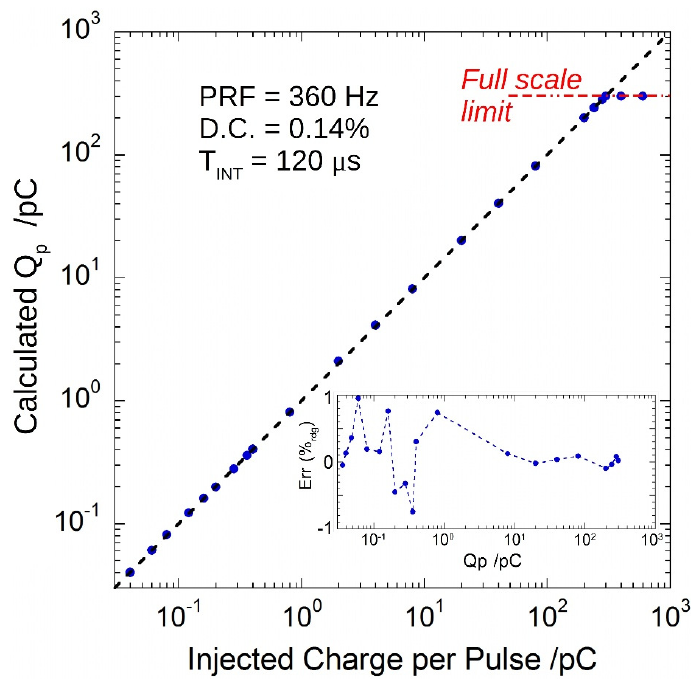
Figure 6. Calculated charge-per-pulse as a function of the injected pulses. Black dashed line represents the expected behavior. In the inset, the percentage of the reading error.